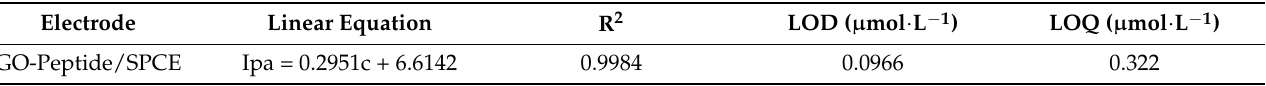
Table 1. Data obtained from the calibration curves for GO-Peptide/SPCE during rosmarinic acid detection. Electrode